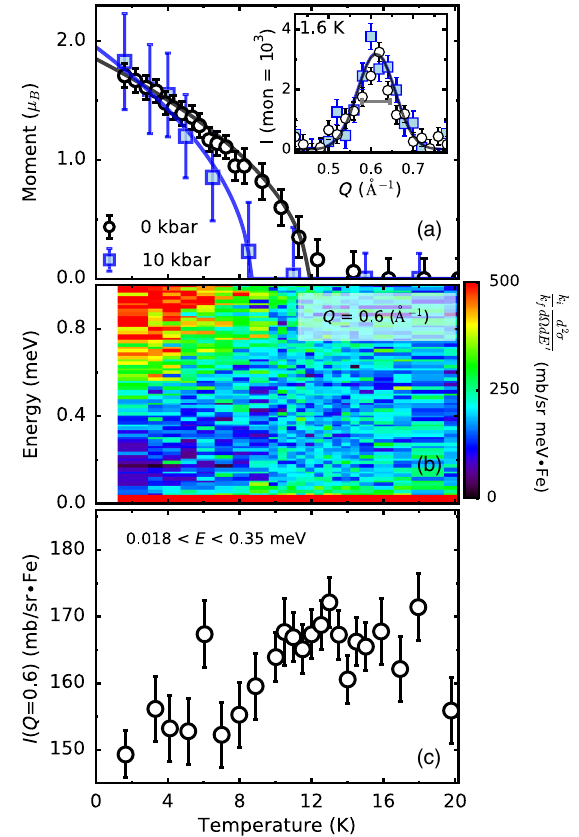
FIG. 6. (a) Temperature and pressure dependence of the ordered magnetic moment in FeSc 2 S 4 , solid lines are a fit to magnetic order parameterwith β ¼ 0 . 54 ð 4 Þ ,saturatedmomentof1.9(1) μ of 11.8(2) and 8.6(8) K for 0 and 10 kbar, respectively. Inset: Background subtracted magnetic Bragg peak measured under 0 and 10 kbar hydrostatic pressure. Horizontal line indicates instrumental resolution. Error bars represent 1 standard deviation. (b) Temperature -dependent low-energy inelastic scattering around the critical wave vector measured on CNCS integrated over 0 . 52 < Q < 0 . 72 Å − 1 . (c) Low -energy integrated inelastic scattering around the critical wave vector integrated over 0 . 52 < Q < 0 . 72 Å − 1 and 0 . 018 < E < 0 . 35